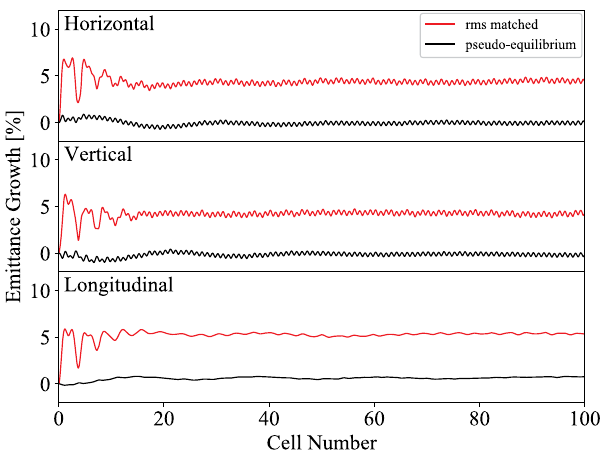
FIG. 13. Time evolution of the projected rms emittances of a 10 MeV proton beam at the operating point ð μ 0 ⊥ ; σ 0 k Þ ¼ ð 60 ° ; 60 ° Þ . The beam initially has the equipartitioned Gaussian distribution whose transverse tune depression is adjusted to η ¼ 0 . 6 . Black curves correspond to the case where the ⊥ phase-space configuration is in the pseudoequilibrium, while red curves to the case of rms matching.